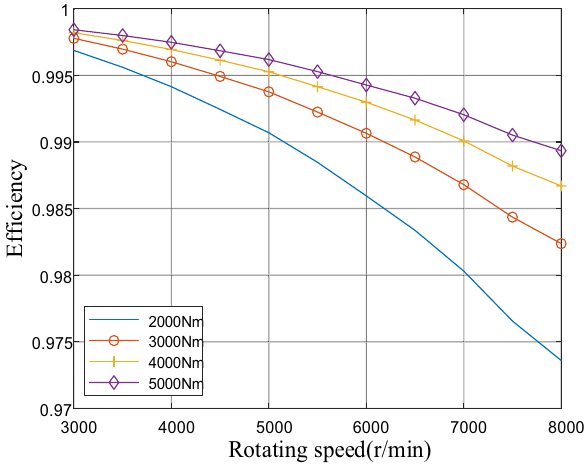
Fig. 6 Influence of normal load per unit of the gear on friction coef- ficient